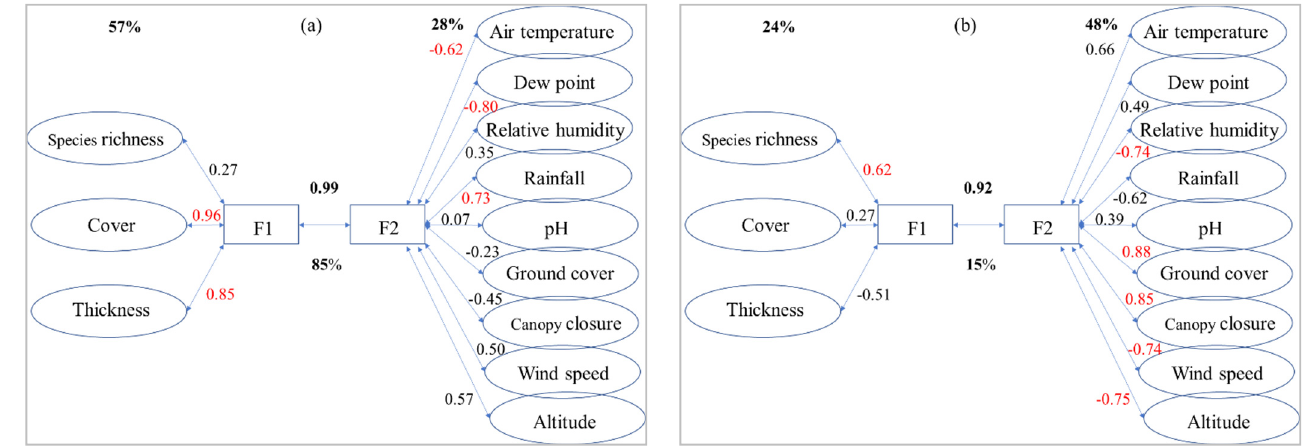
Figure 5. Structure of the first ( a ) and second ( b ) canonical variables sets of the CCA.